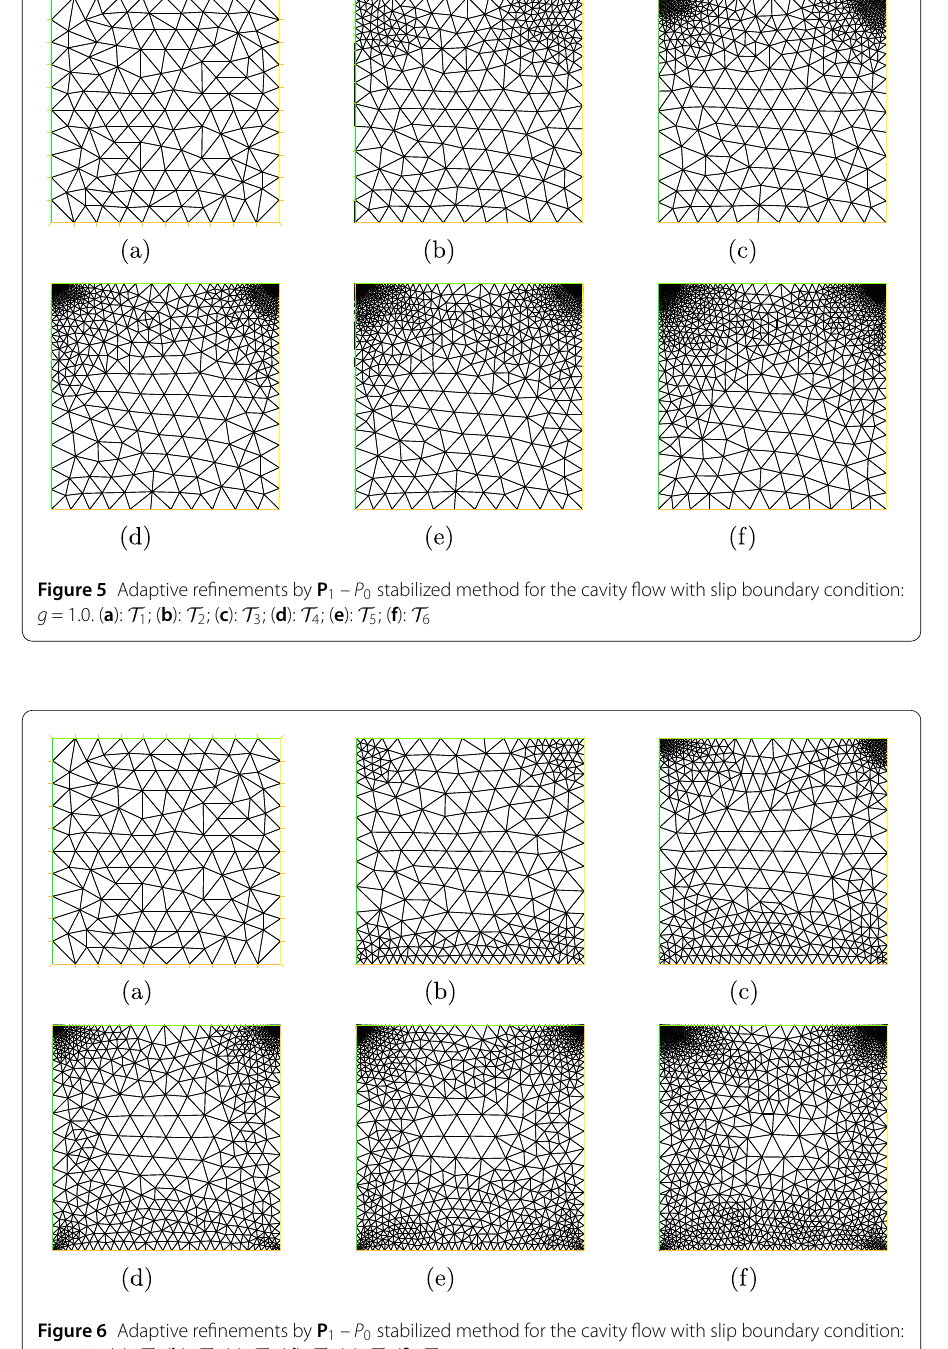
inative factor as the given scalar function g increases. The adaptive refinements for the two stabilized methods are similar, which means both stabilized methods with adaptive strategy are effective to solve the incompressible flow with the slip boundary conditions of friction